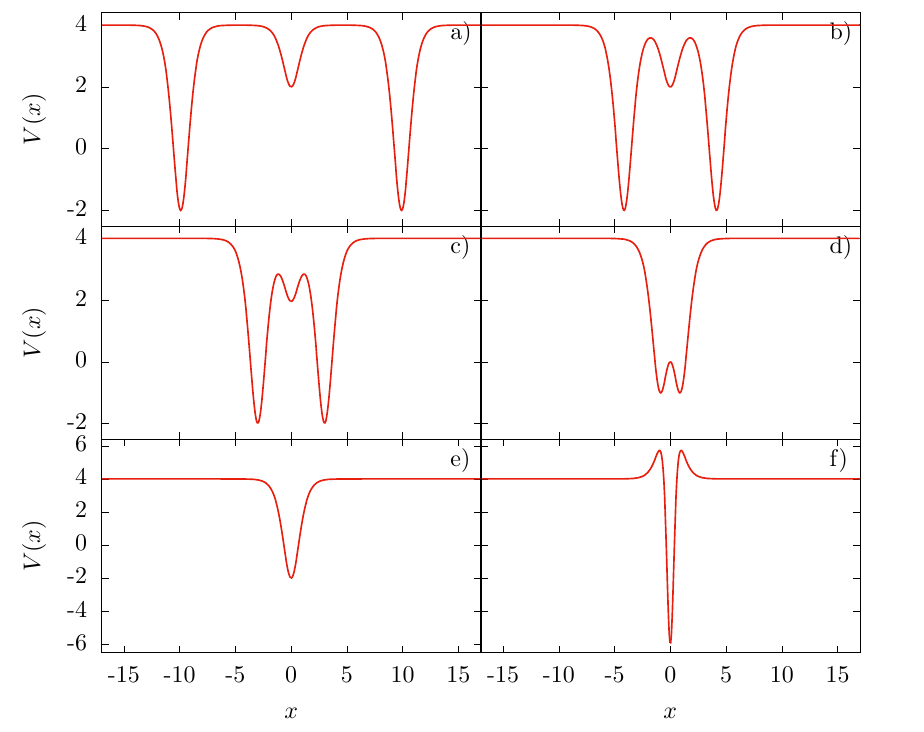
Figure 8 . The e(cid:11)ective potential for the annihilating impurity j = 1 for a = 10 8 ; 10 4 ; 10 2 ; 1 ; 0 ;